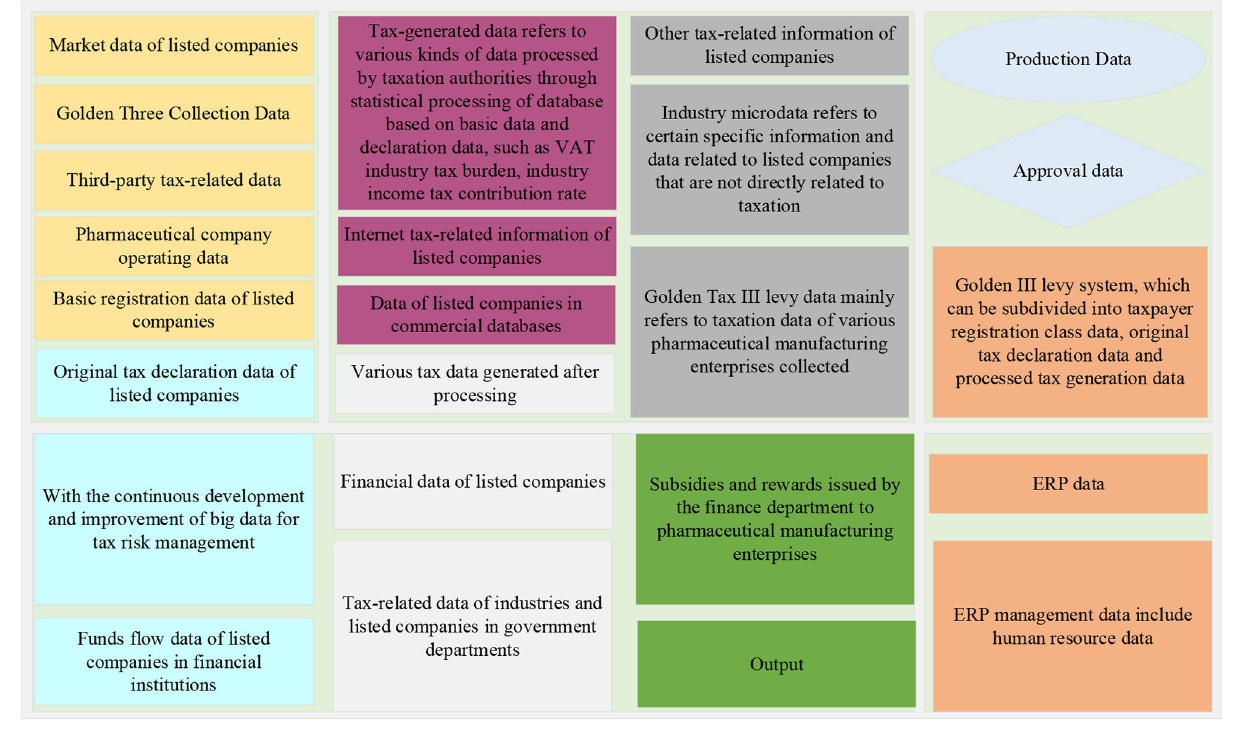
FIGURE 1 | Classification of listed companies’ financial taxation big